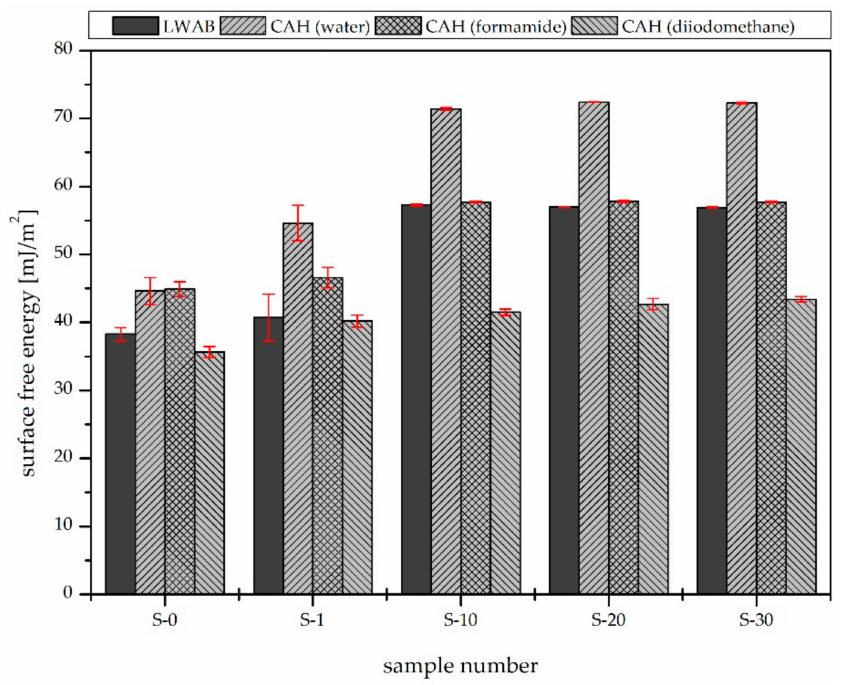
Figure 4. Surface free energy calculated using the LWAB and CAH approaches.